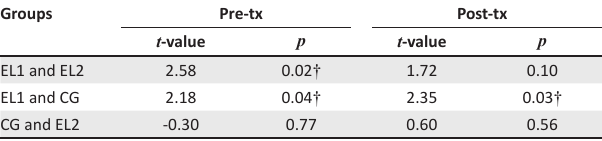
TABLE 4: Results of t -tests for significant differences between groups on Phonological Segmentation scores. Groups